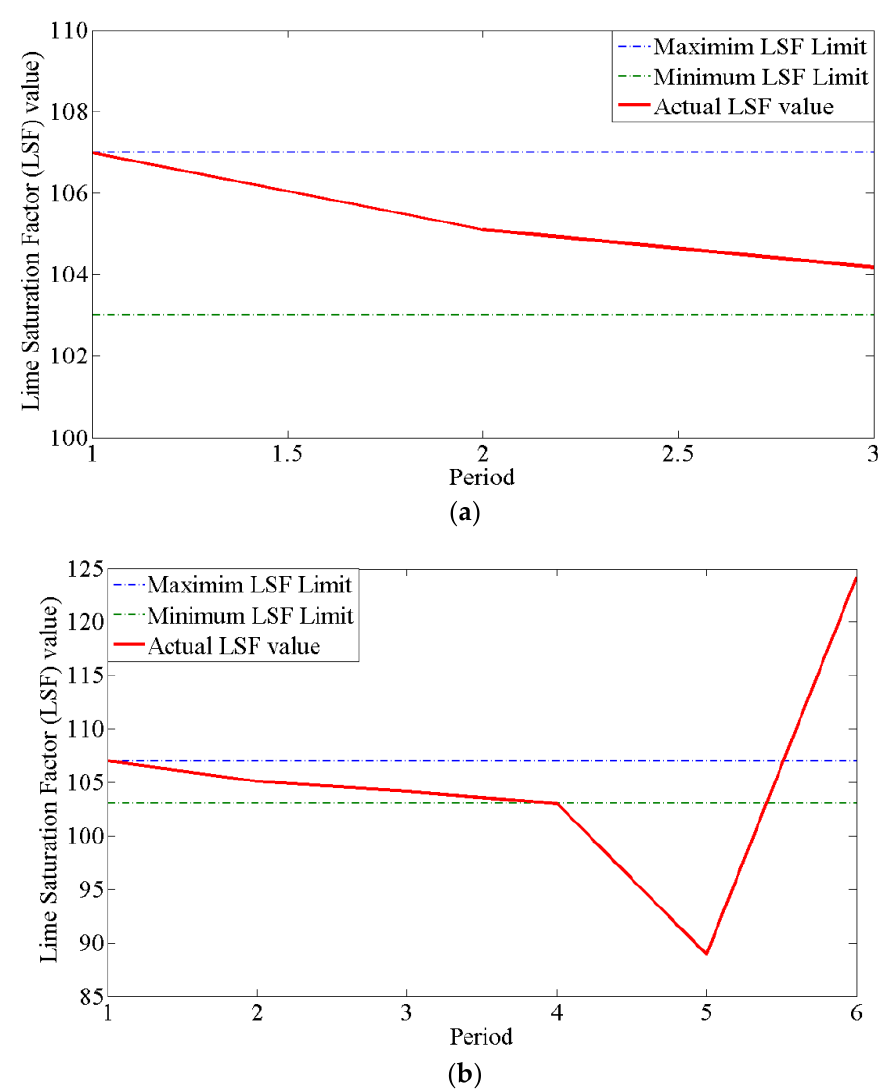
Figure 6. ( a ) Model 1 LSF value up to three periods with the LSF bound; ( b ) Lime saturation (LSF) value up to six periods from Model 1 with bound of LSF.